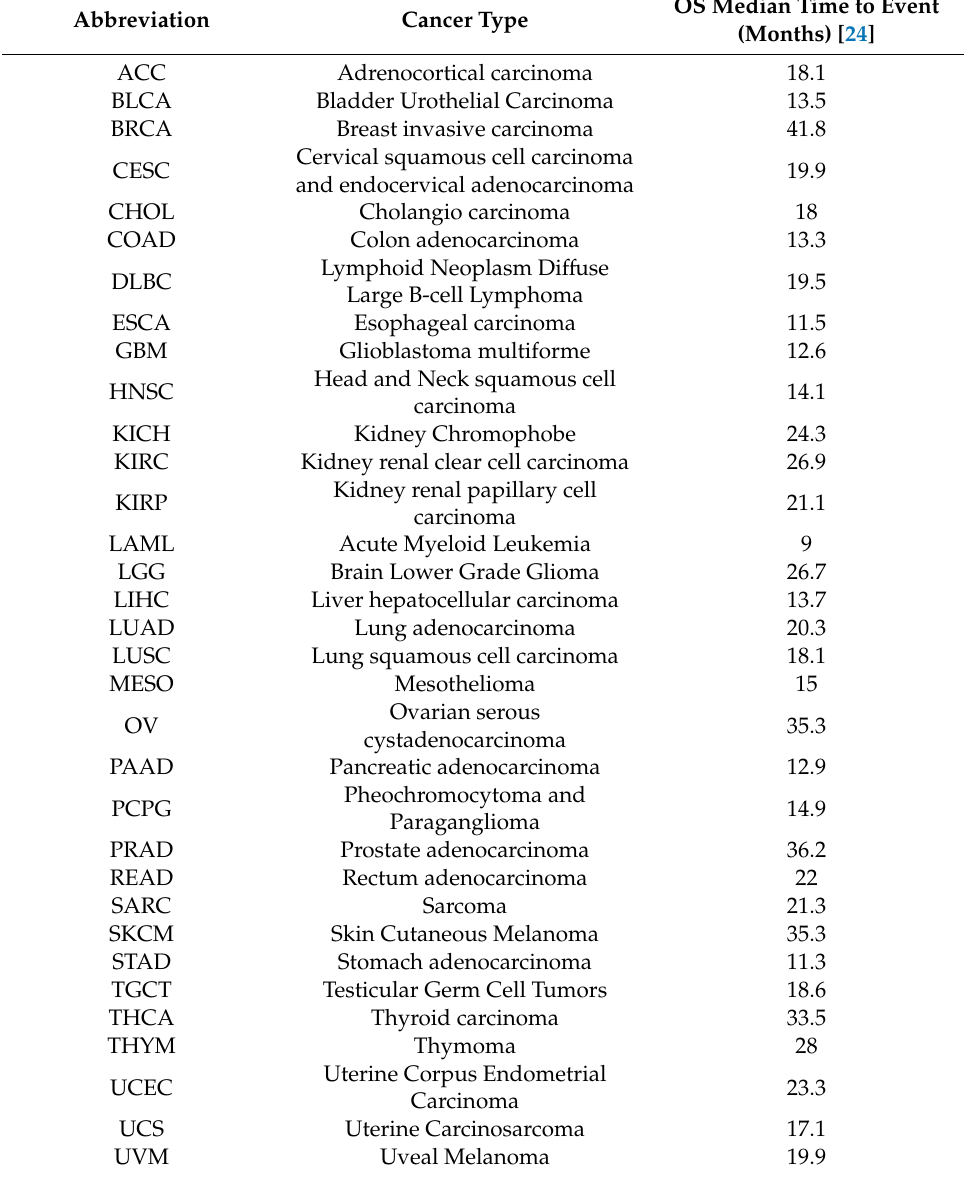
Table 1. Description of cancer type abbreviations used by the Cancer Genome Atlas